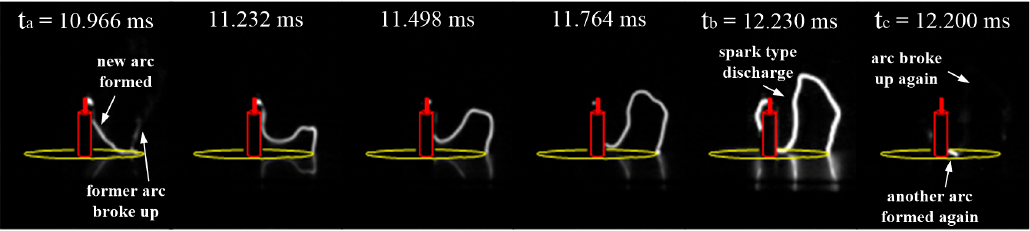
Figure 8. Simultaneous images of gliding arc topologies captured by a high-speed camera when average flow rate in stable mode was 120SLM (sample rate: 30,000 fps, exposure time: 29.23 μ s). Figure 9 analyzes the variation of average power of the gliding arc discharge with di ff erent